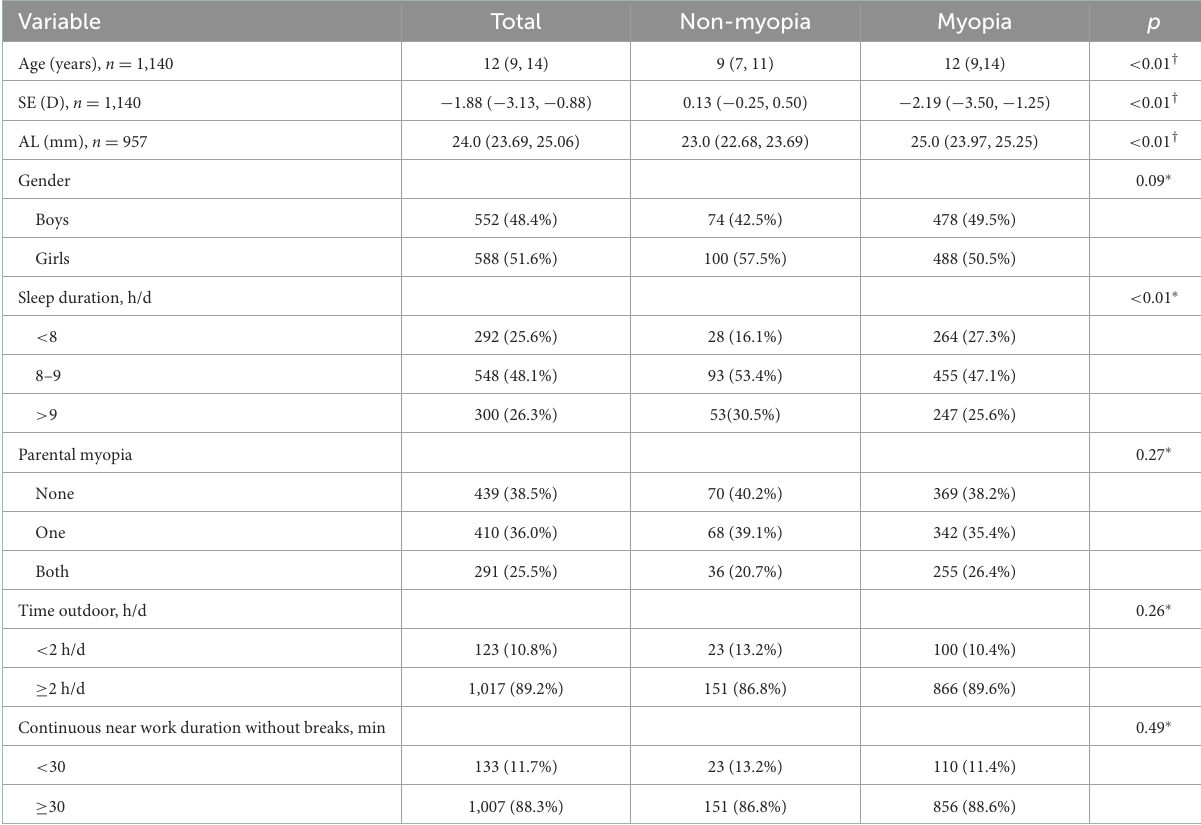
TABLE 1 Characteristics of children stratified by myopia status. Variable Total